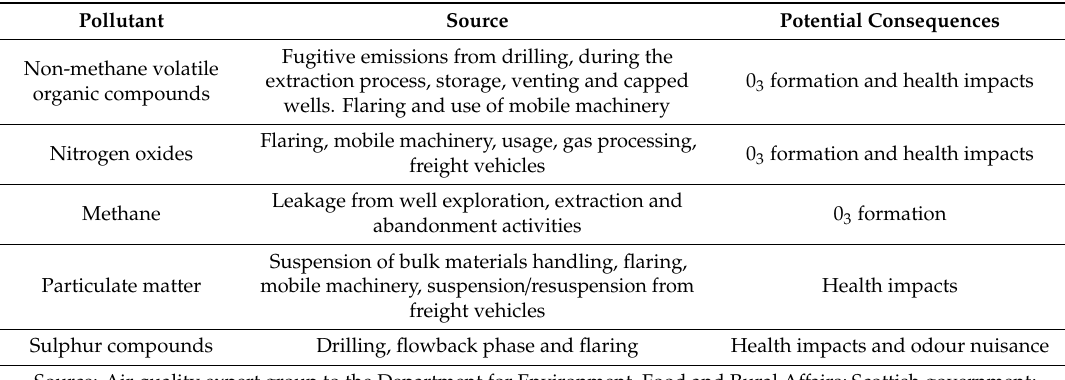
Table 3. Air Quality pollutants from shale gas